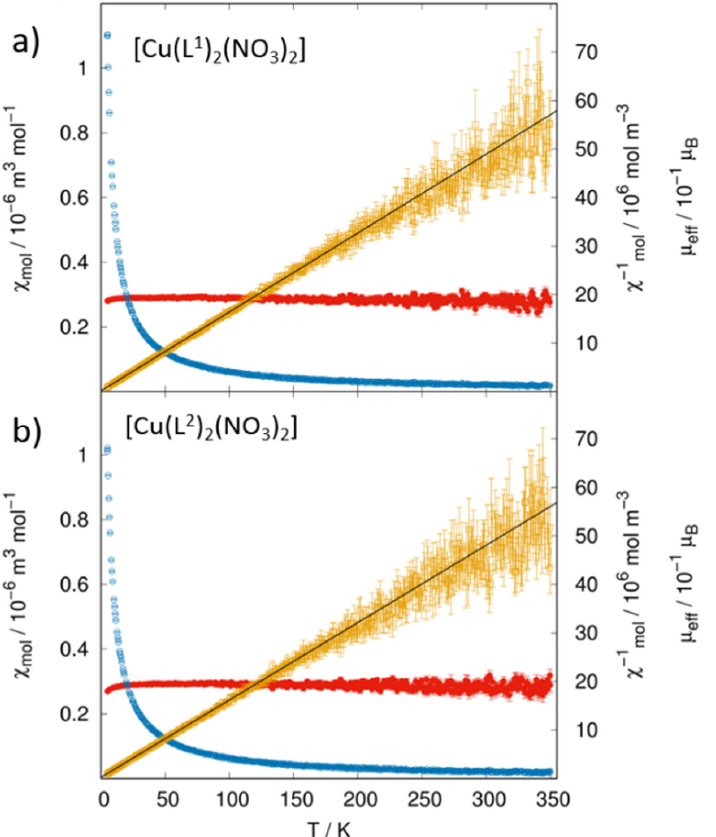
Figure 6. Molar susceptibilities (blue circles) and inverse molar susceptibilities (orange squares) of ( a ) CuL 1 and ( b ) CuL 2 with fits according to the Curie–Weiss law (black solid line). The red curve represents the effective magnetic moments (in μ B ).